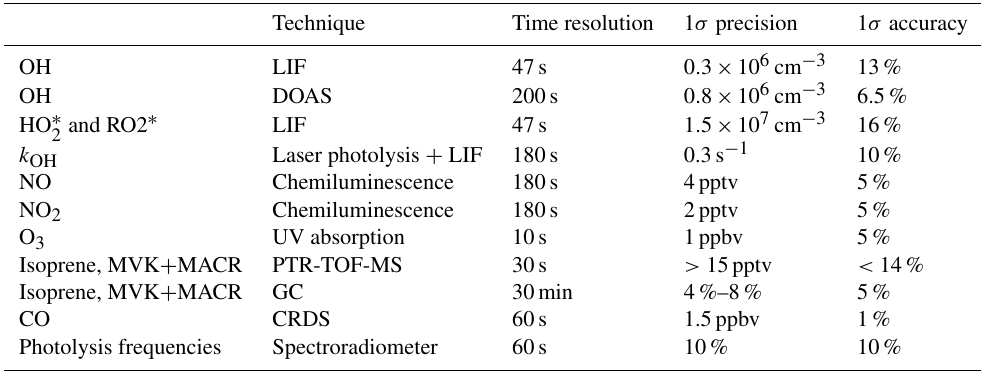
Table 4. Instrumentation for radical and trace gas quantification during the oxidation experiment.